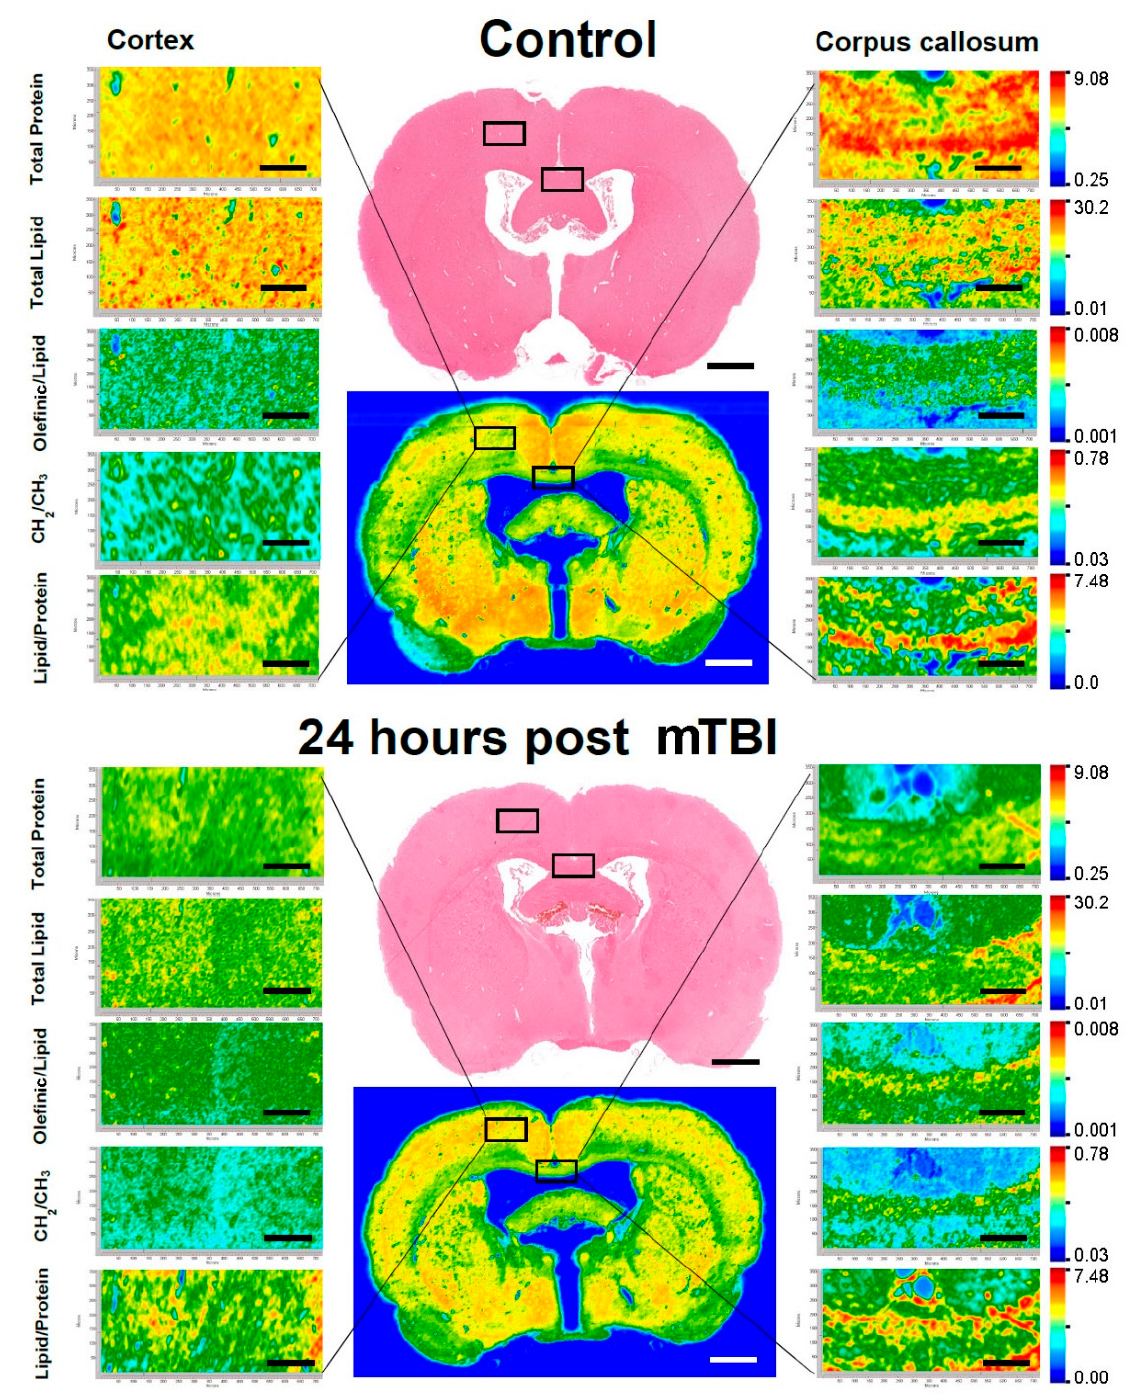
groups. In Figure 3, the left-hand side represents the focused FTIR images of Co; thew right-hand side represents images from CC, extracted from the control (top) and 24 h post-mTBI (bottom) brains. Exact areas of analyses are marked with black squares for the Co and CC regions.